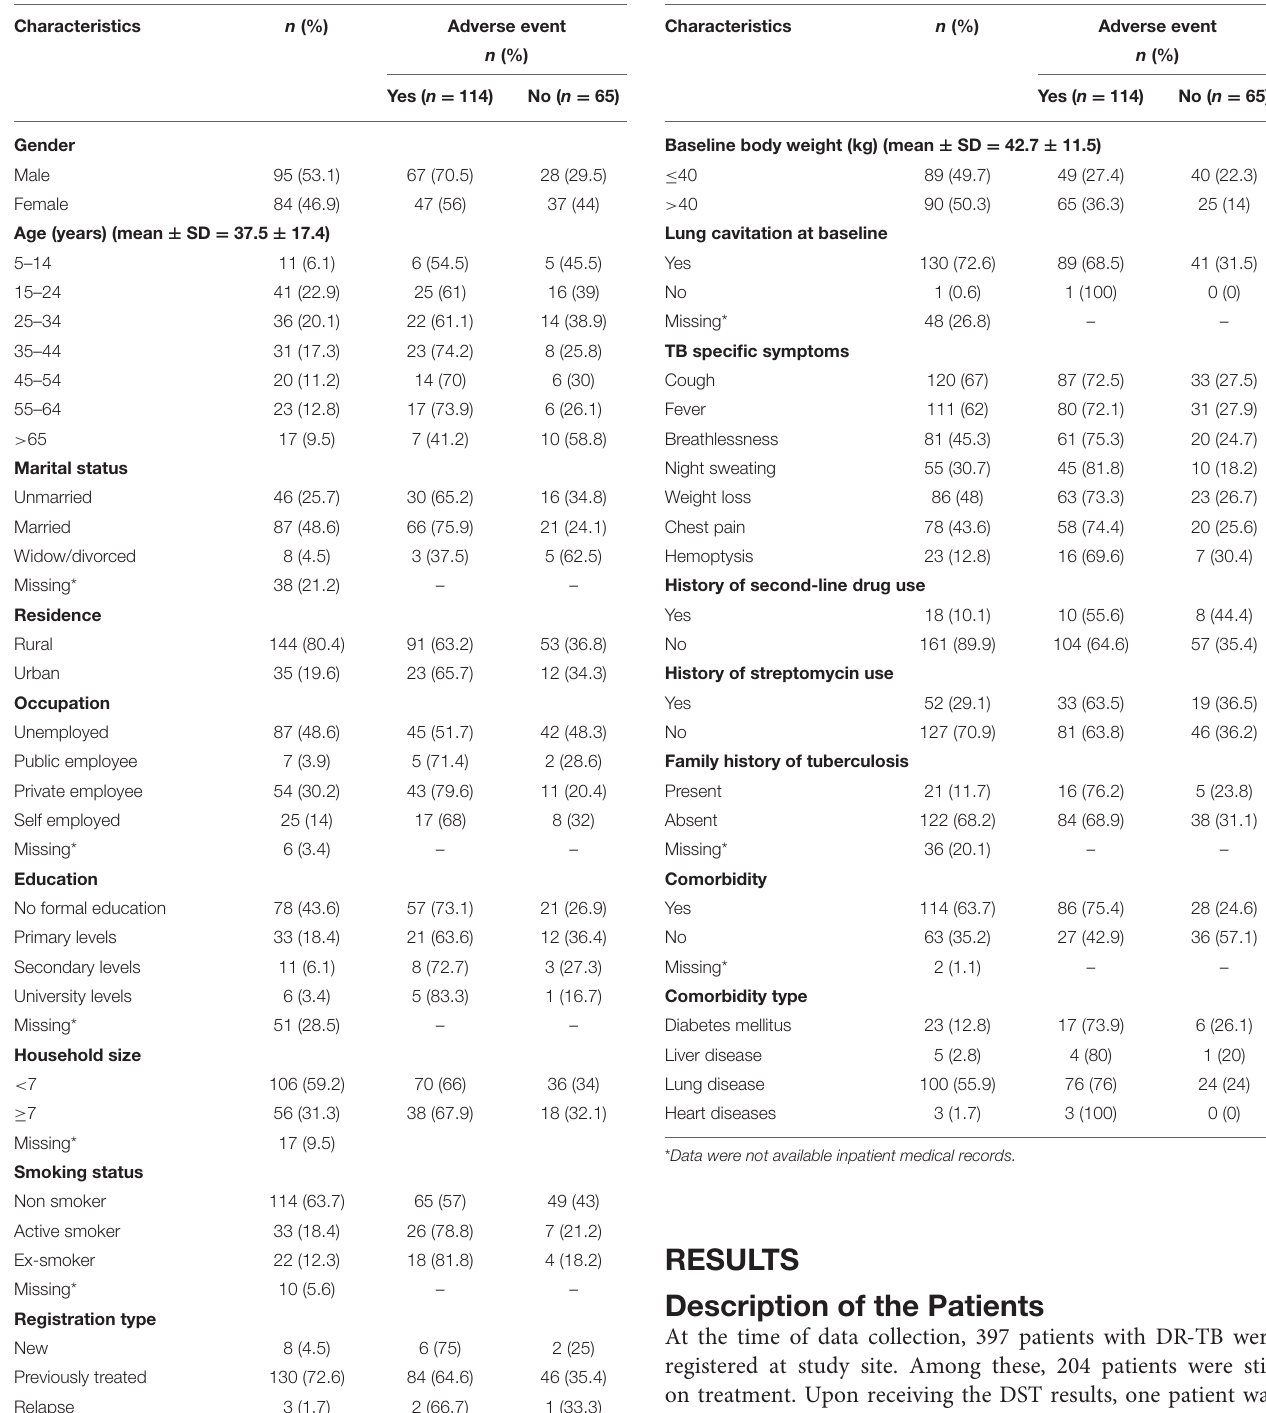
TABLE 2 | Patients’ characteristics and occurrence of adverse events ( n =